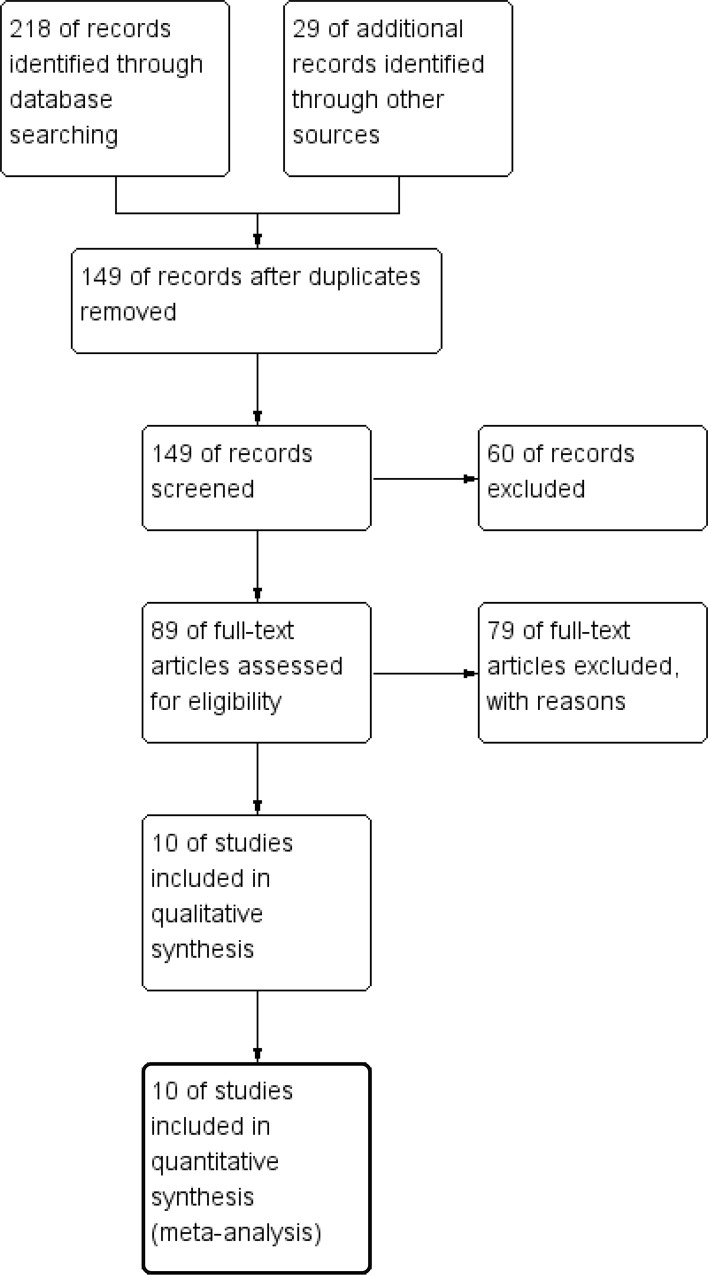
Flow chart for the selection of records to include.